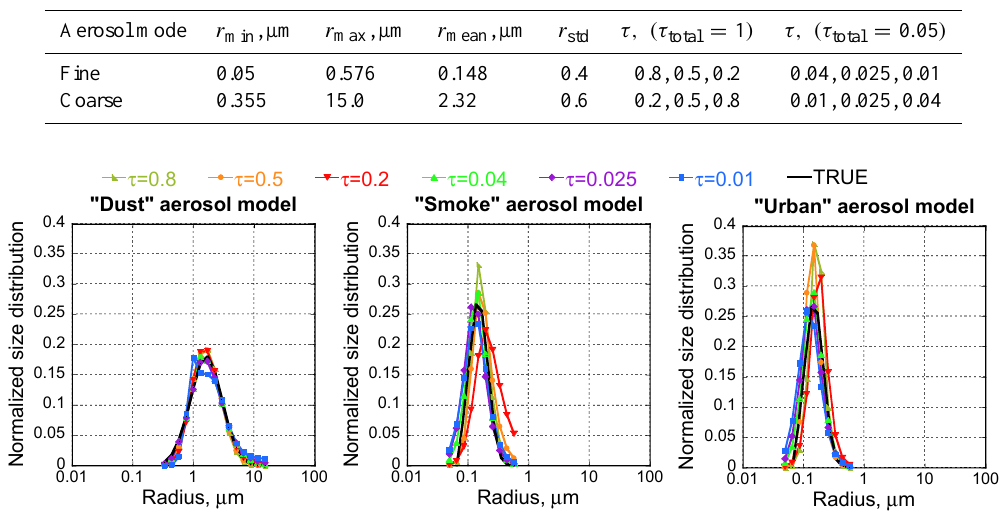
Fig. 4. Retrievals of size distributions of “Dust”, “Smoke” and “Urban” aerosol models under different AOT.